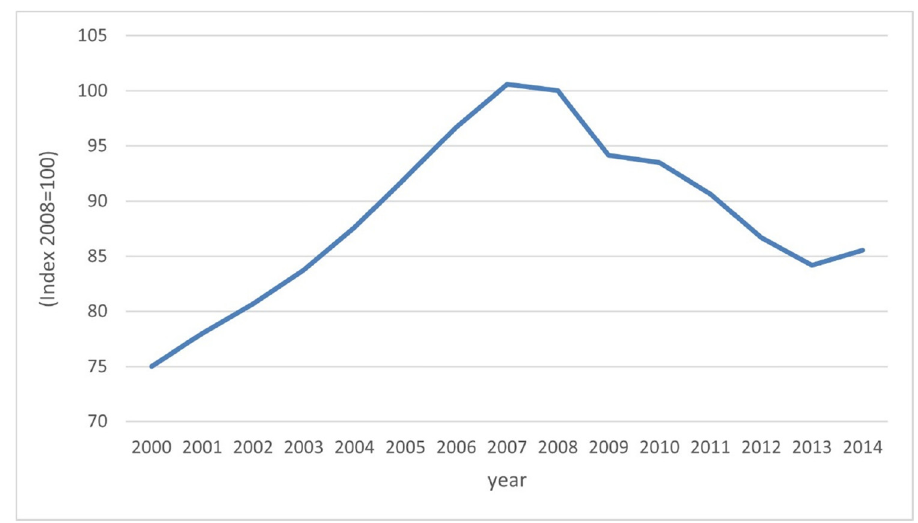
Figure 5: Evolution of the internal demand in Spain. Source: AMECO -